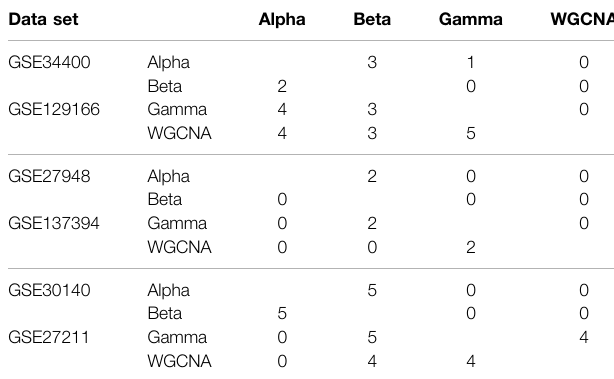
TABLE 2 | Overlapping in the fi ve GO terms of the top module for each pair of pipelines. Each table contains two data sets: the fi rst data set is shown in the upper-triangular part of the table, and the second in the lower-triangular part. For instance, the number of GO terms shared between WGCNA and Gamma in GSE27211canbefoundinthecorrespondingcellofthelowerpartofthethird table ( (cid:2) 4 in this